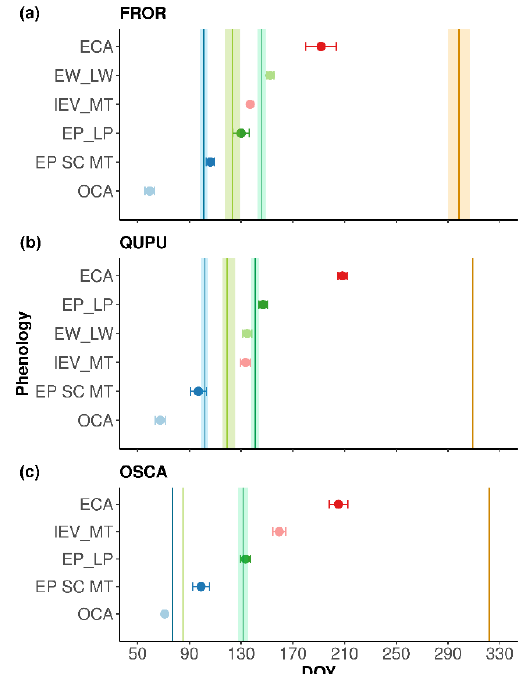
Figure 2. Main leaf phenological phases and timings of xylem and phloem formation for ( a ) Fraxinus ornus (FROR); ( b ) Quercus pubescens (QUPU) and ( c ) Ostrya carpinifolia (OSCA) in Podgorski Kras in 2019. SB—swollen buds (blue line); LE—leaf emergence (light-green line); LU—leaf unfolding (dark-green line); AC—autumn leaf coloring (orange line); OCA—onset of cambial activity (light-blue dot); EP SC MT—time when initial sieve tubes reached final size (dark-blue dot); EP_LP—transition from early phloem to late phloem (dark-green dot); IEV_MT—mature initial earlywood vessels (light red dot); EW_LW—transition from earlywood to latewood (light-green dot); ECA—end of cambial activity (dark-red dot). Table 2. Phenological phases (DOY = day of the year) of leaf development and of xylem and phloem formation (mean ± standard deviation). Phenological phases marked with the same letters are not significantly different (α ≤ 0.05).